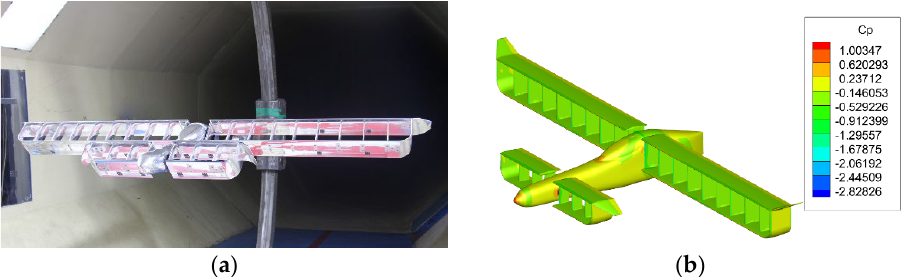
Figure 22. The 1:10 scale model without ducted fans to verify the CFD results. ( a ) Wind tunnel model; ( b ) CFD simulation model.